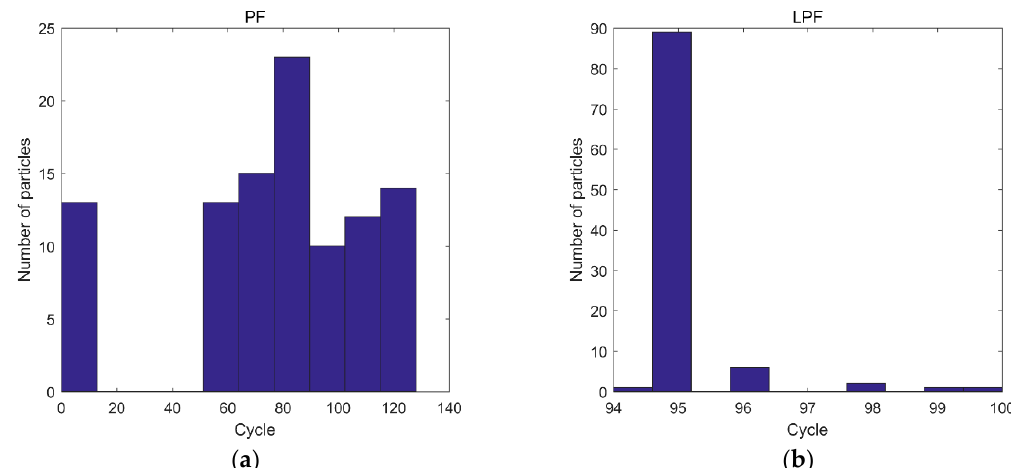
Figure 7. Histograms of predicted RUL distribution for battery B18, using 100 particles and 33 observations for the particle filter (PF) and the LPF methods: ( a ) PF; ( b ) LPF.